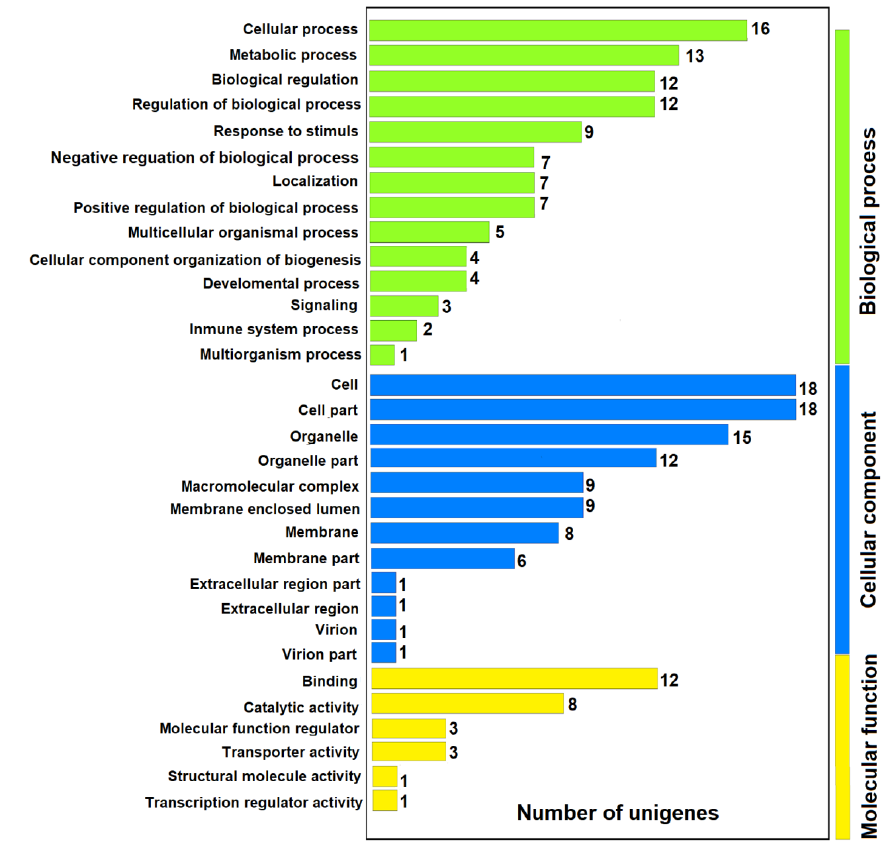
Figure 6. Distribution by categories of the GO classification of the 83 differentially expressed genes (DEGs). The number of unigenes in each category is shown.